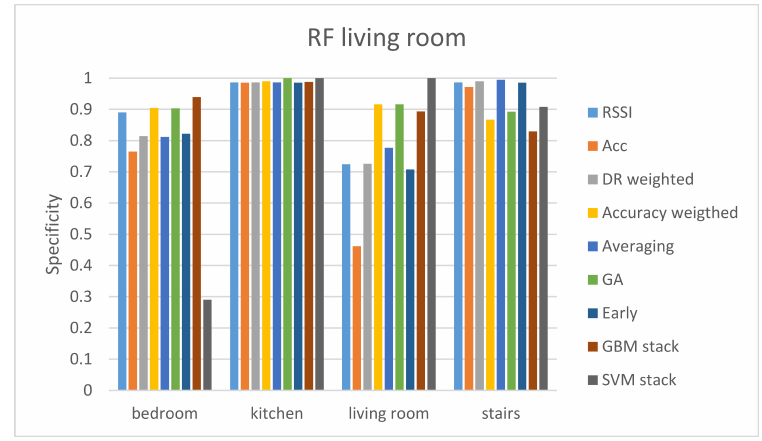
Figure 3. Specificity results of the RF classifier for the living room gateway.